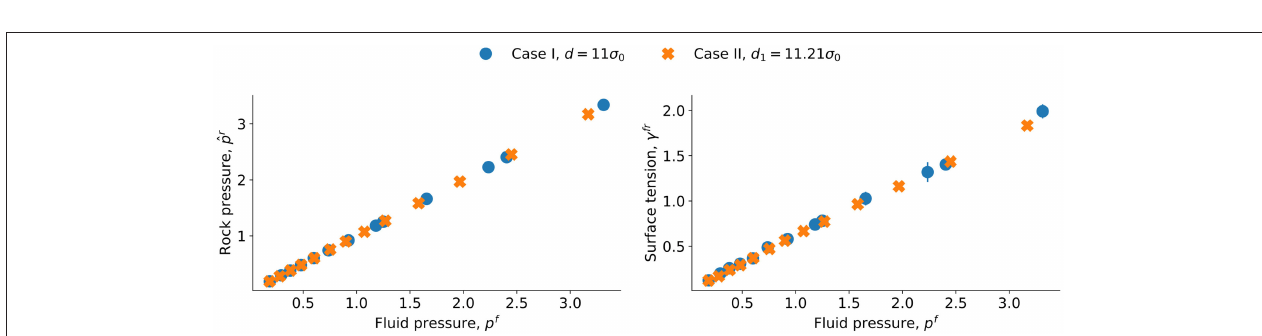
4.14 σ 0 and d 1 11.21 σ 0 ). = =